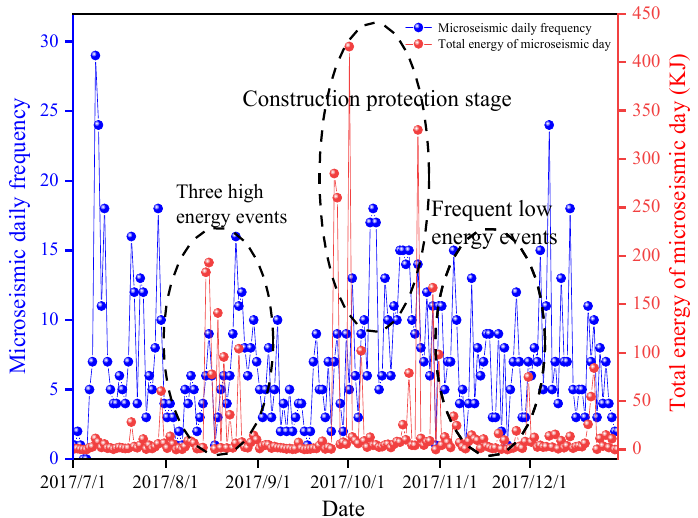
Figure 10. Time-dependent Evolution Curves of Microseismic Events in the Main Roadway Zone.